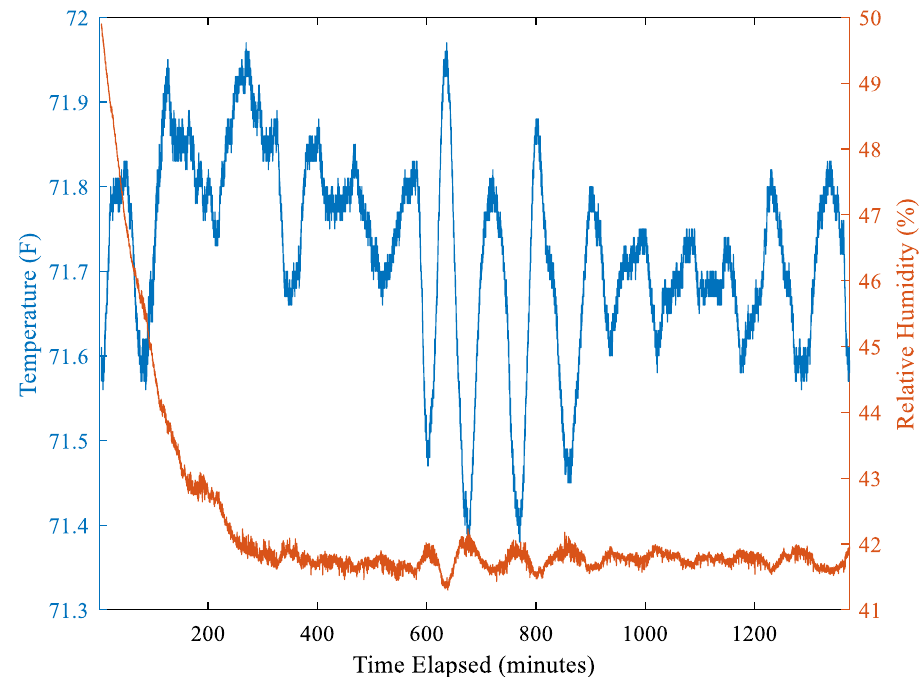
Figure 3. Example data readout of temperature and RH over 22 h, 10 L/min at 50% RH.